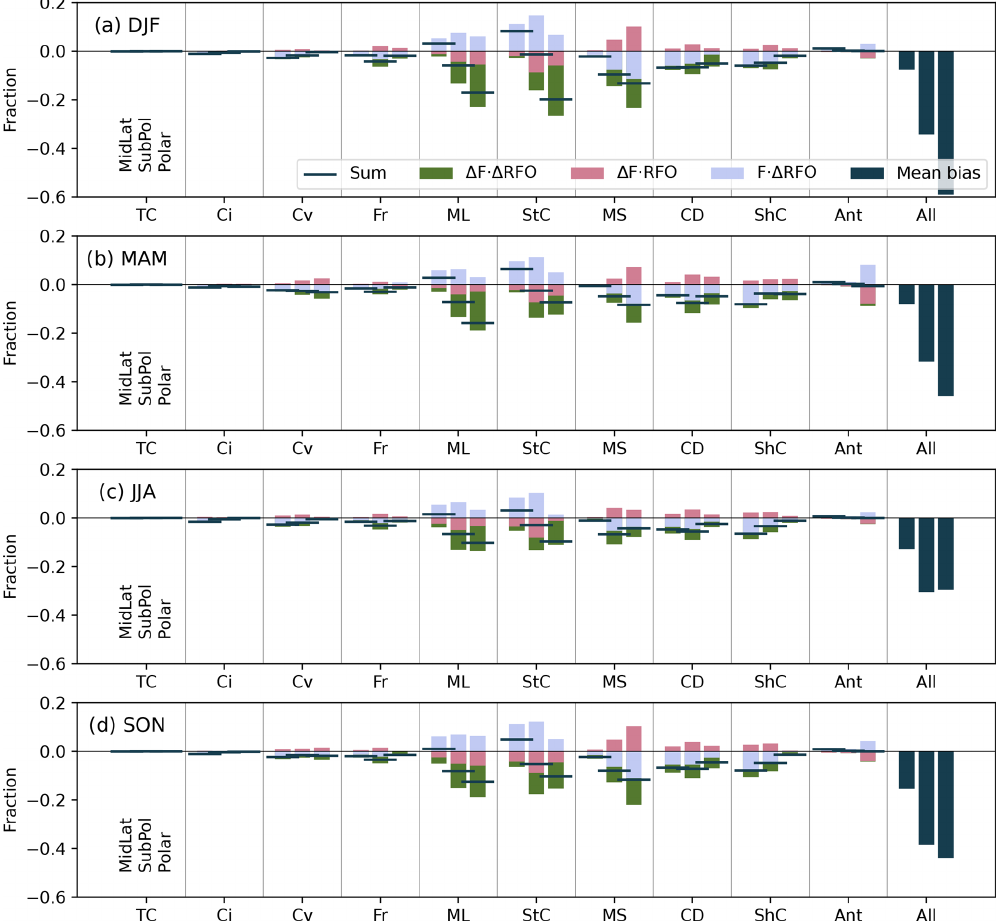
Figure A1. The decomposed mean biases in the CFL (fraction) for each cloud regime (thin cirrus, TC; cirrus, Ci; convective, Cv; frontal, Fr; mid-level, ML; stratocumulus, StC; marine stratiform, MS; cloud decks, CD; shallow cumulus, ShC; Antarctic, Ant) over the three regions from left to right mid-latitudes, sub-polar and polar, for each season (DJF, a ; MAM, b ; JJA, c ; SON, d ). The sum of the decomposed biases is shown by the horizontal bar, while the terms of the bias decomposition (see Eq. 1) are shown in blue ( F sat r · (cid:49) RFO r ), pink ( (cid:49)F r · RFO sat r ) and green ( (cid:49)F r · (cid:49) RFO r ). On the far right of each plot is the mean radiative bias for each region/season as a